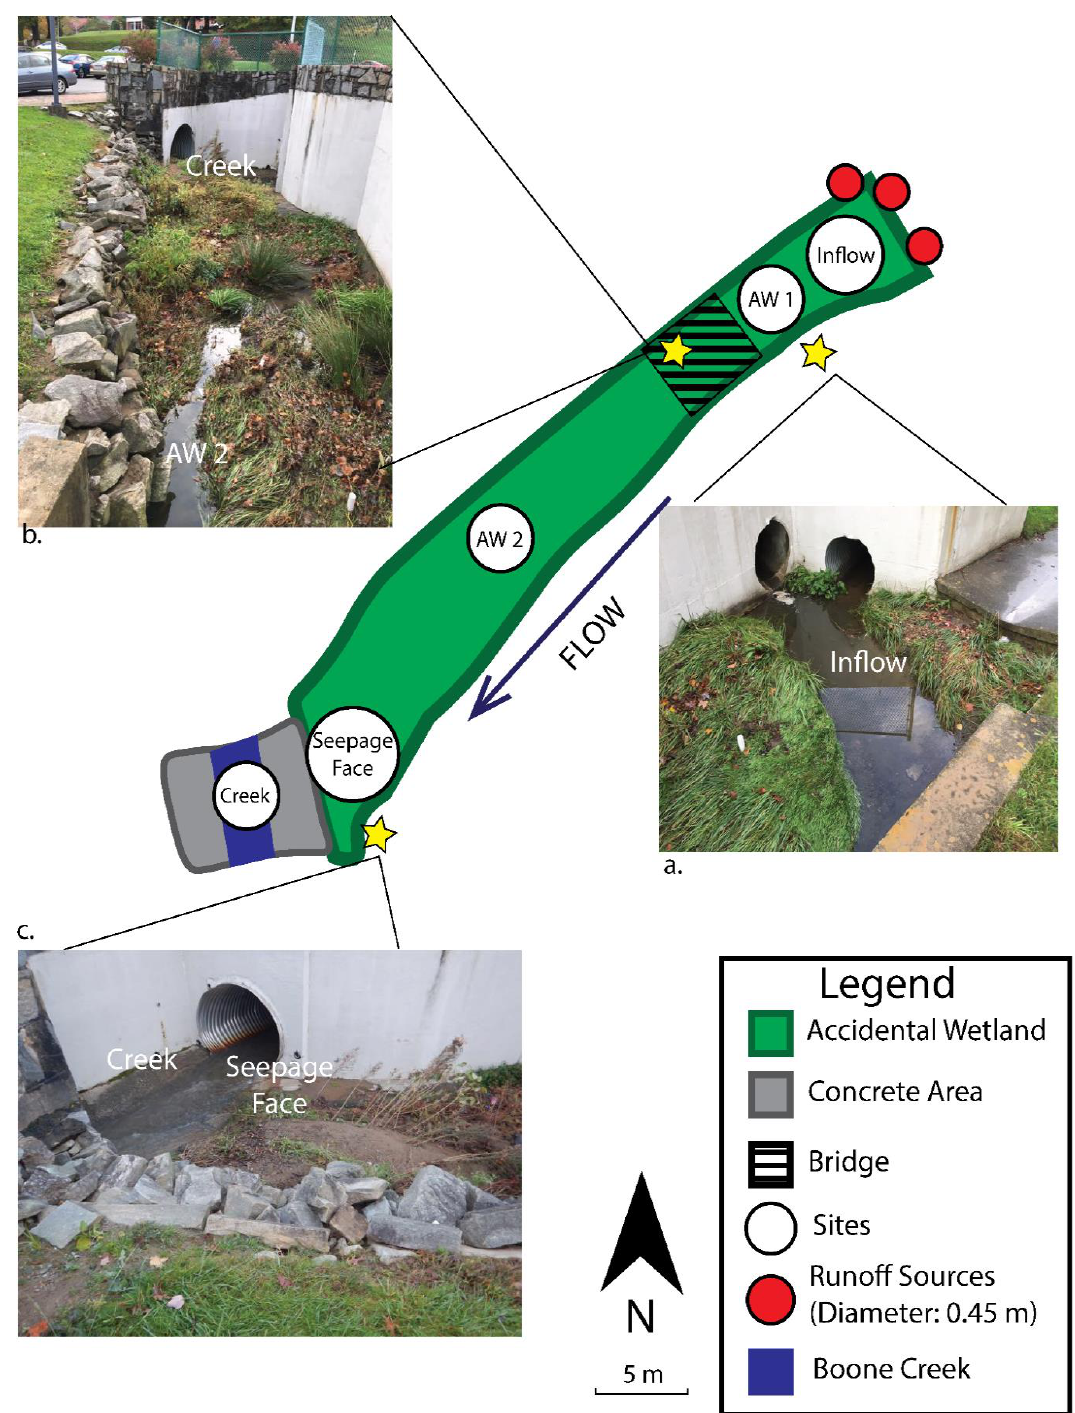
Figure 5. A map of the Accidental Wetland (AW). The stars indicate the locations from which the pictures were taken. Red circles indicate runoff surfaces at the inflow area of the wetland. The sites, denoted by white circles, were named Inflow, Accidental Wetland Site 1 (AW 1), Accidental Wetland Site 2 (AW 2), Seepage face, and Boone Creek. ( a ) Facing upstream towards the stormwater culverts, or the inflow sources. ( b ) Standing on bridge facing downstream towards seepage face and Boone Creek. ( c ) On grass facing Boone Creek stormwater culvert and the seepage face. The diameter of the culvert is 1.5 m.